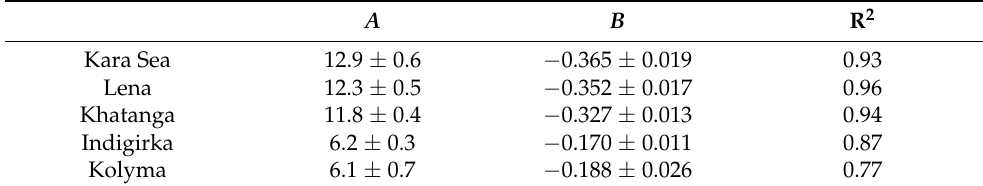
Table 3. Coefficients a and b of the a CDOM (350) = a + b × Salinity regression line and corresponding coefficients of determination obtained for the Kara, Laptev, and East Siberian seas during August– September